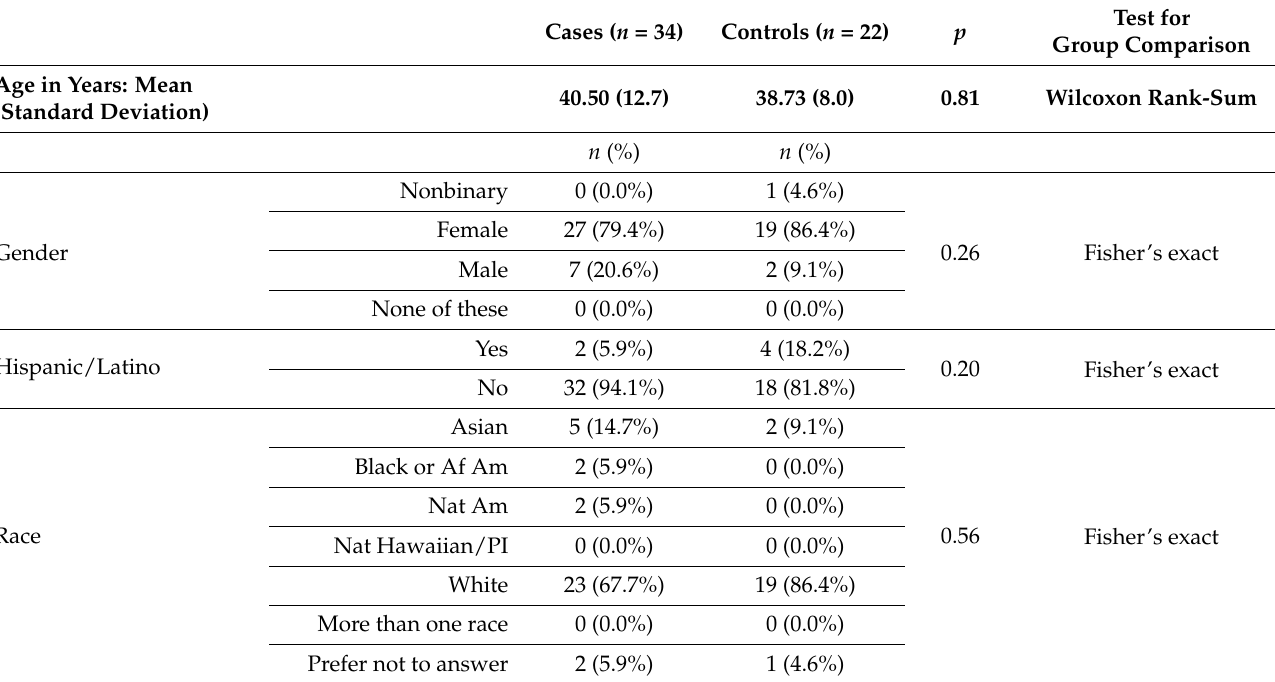
Table 1. Demographic information.